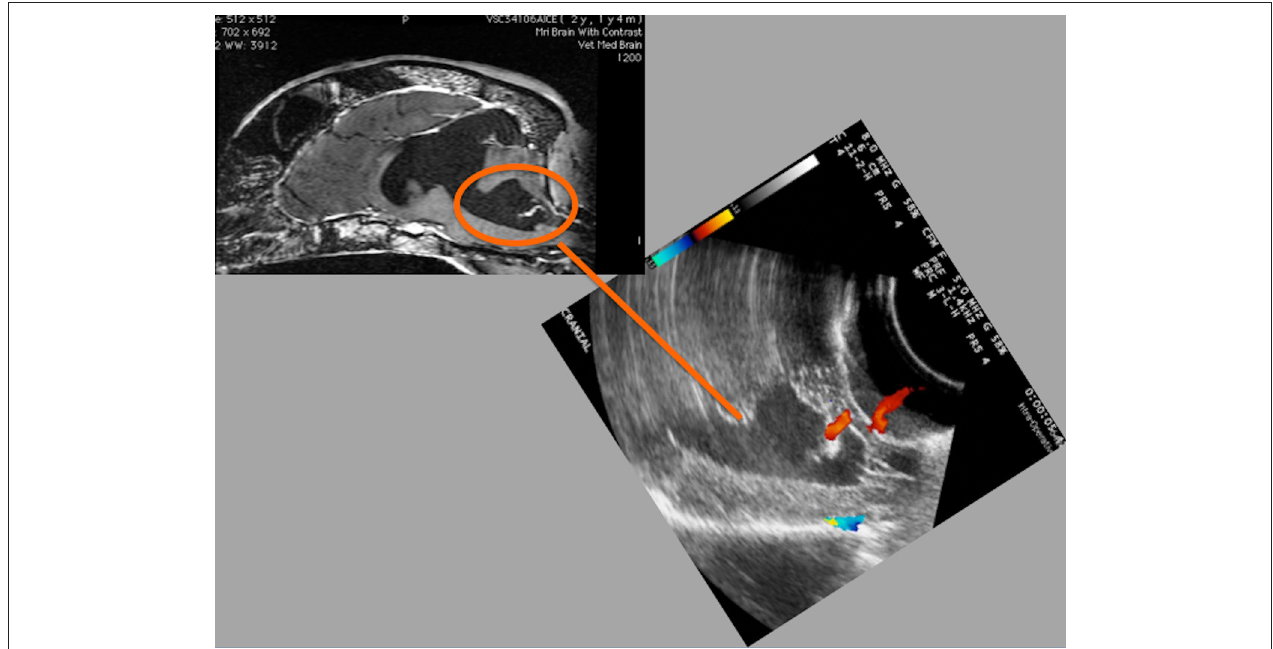
FIGURE 6 | Case 21. Left, T1 sagittal MRI. Right, accompanying IOUS image. There is moderate fluid dilation of the fourth ventricle, measuring up to 1.8cm in height (orange circle on MRI with line connecting to corresponding area on ultrasound image). There is additional fluid dilation present dorsal to the colliculi. Moderate blood flow is seen on color Doppler integration surrounding the dilated fourth ventricle. The surrounding brain parenchyma is mildly hyperechoic.